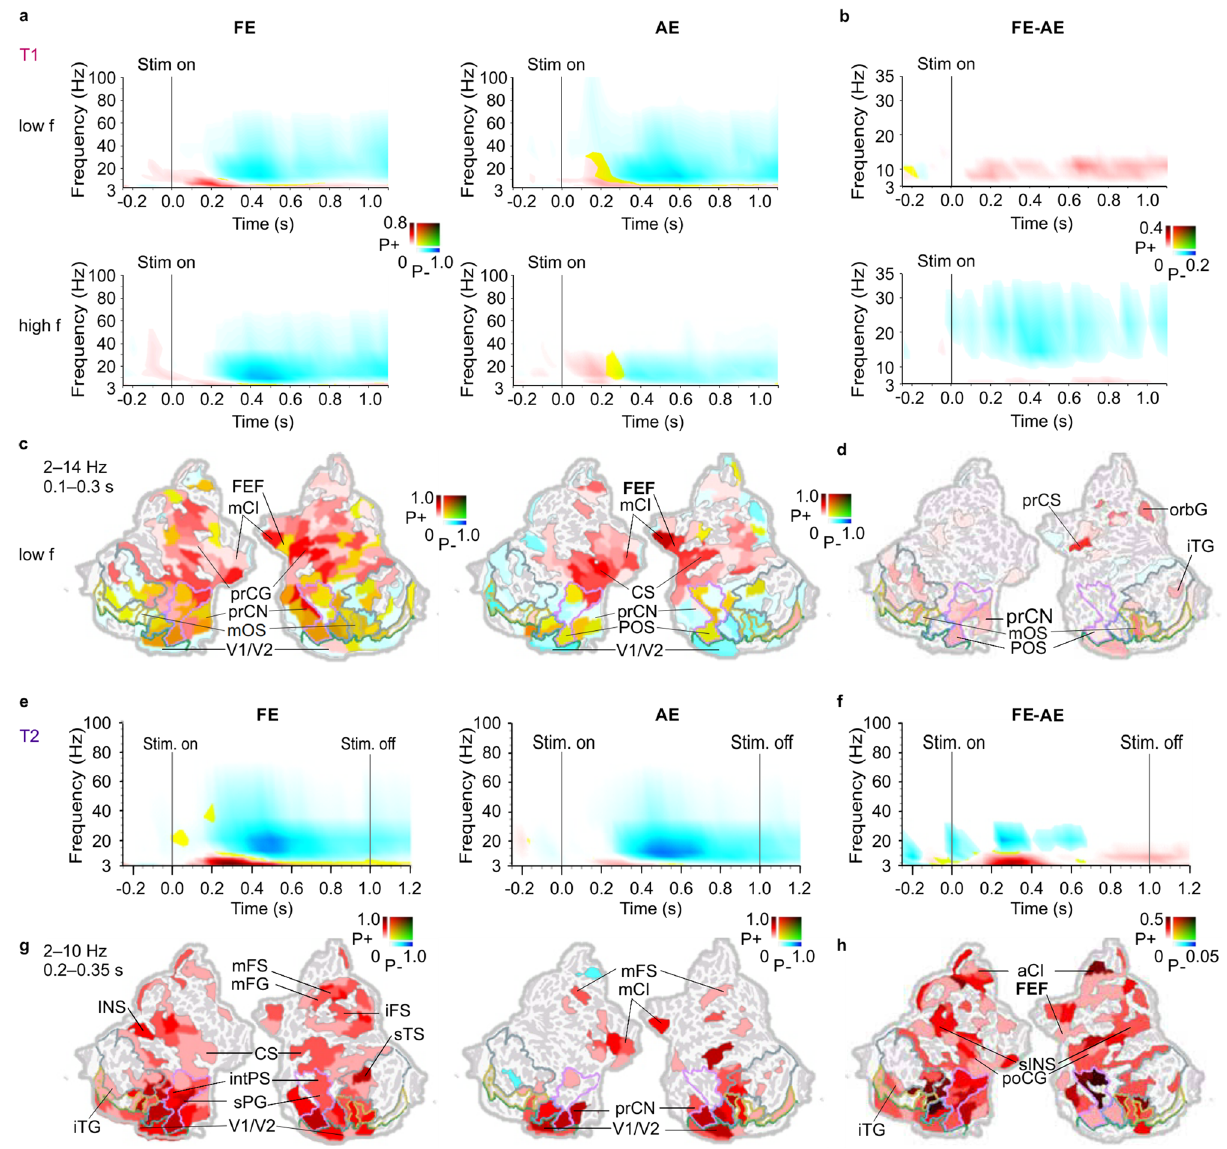
Figure 3. Oscillation amplitudes are stronger for FE than AE. ( a ) Time–frequency representations (TFR) for spectrally resolved oscillation amplitude modulations separately for stimuli presented to the FE and AE compared to baseline ( t -test, threshold p < 0.05, FDR corrected) for T1. Colour codes show the fraction of parcels with statistically significant positive (P+, red) or negative (P−, blue) modulation or their mixture (yellow/green) and the coloured lines define boundaries for functional visual regions of interest as in Fig. 2. ( b ) TFRs for the difference in oscillation amplitudes between FE and AE ( t -test, threshold p < 0.05, FDR corrected). ( c ) Cortical sources for oscillation amplitudes averaged over time and frequency selections indicated in A for FE ( t -test, threshold p < 0.01, FDR corrected) and for AE ( t -test, threshold p < 0.05, FDR corrected). Colours indicate the strength of the amplitude modulation for positive (P+, red), negative (P−, blue) difference as well as the presence of both (yellow/green). ( d ) Cortical sources showing differences in oscillation amplitudes between FE and AE ( t -test, threshold p < 0.05, FDR corrected) averaged over time and frequency selections indicated in ( b ). ( e–h ) Same as ( a – d ) but for the T2. A anterior, la lateral, m middle, i inferior, int intra, orb orbital, po post, pr pre, s superior, CI cingulate, CN cuneus, FEF frontal eye field (posterior part of superior prefrontal sulcus), INS insula, C central, F frontal, P parietal, T temporal, O occipital, G gyrus, S